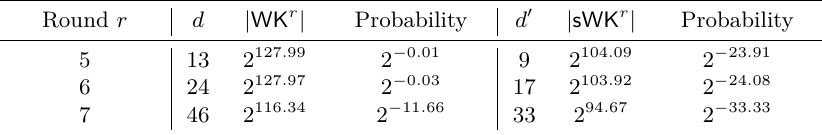
Table 6: Total number of weak keys (lower